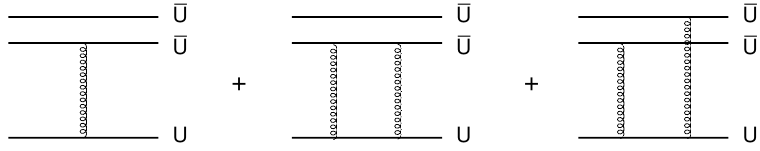
Figure 6. A representative diagram for scattering of a single target gluon in the dense-dilute limit. Here we have drawn the target gluon on the bottom of the (cid:12)gure and the projectile gluons at the